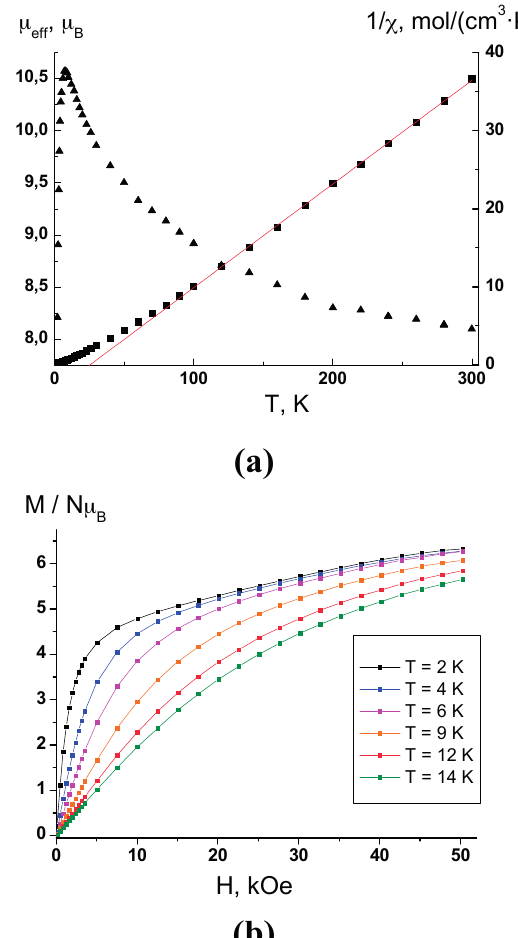
Figure 4. Temperature dependences of µ eff and 1/ χ ( a ) and M(H) at different temperatures ( b ) for [ С o 3 (Piv) 2 L 1 2 L 2 2 ]·2Me 2 CO. For [Co 5 (Piv) 4 L 1 2 L 2 4 ] · 0.5Me 2 CO · 0.5 С 7 H 16 , µ eff is 9.99 µ B at 300 K and gradually increased to